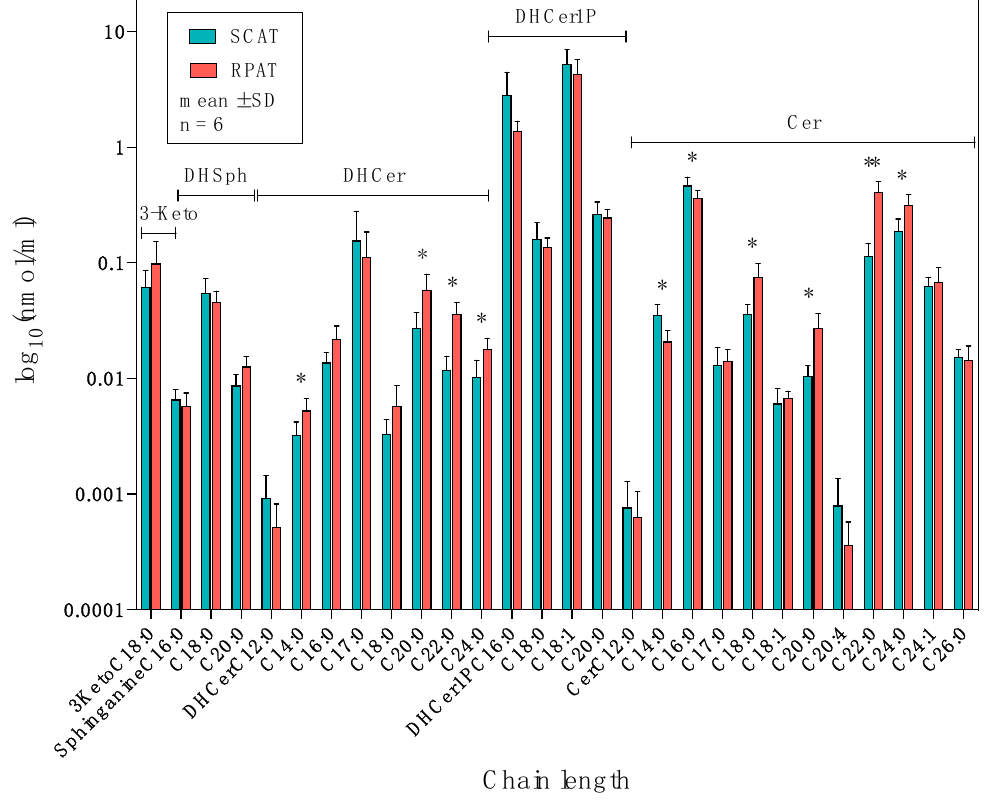
Figure 4. The distribution of sphingolipids in the de novo synthesis pathway in subcutaneous (SCAT) and retroperitoneal adipose tissue (RPAT) in German Holstein bulls ( n = 6). Data are presented as the mean ± standard deviation (SD) on a logarithmic scale. 3-Keto: 3-ketosphinganine concentration; DHSph: sphinganine concentration; DHCer: dihydroceramide concentration; DHCer1P: dihydroceramide-1-phosphate concentration; Cer: ceramide concentration. Asterisks indicate significant differences (* p < 0.05; ** p < 0.01) between two adipose tissues by paired Student’s t -test with FDR correction.